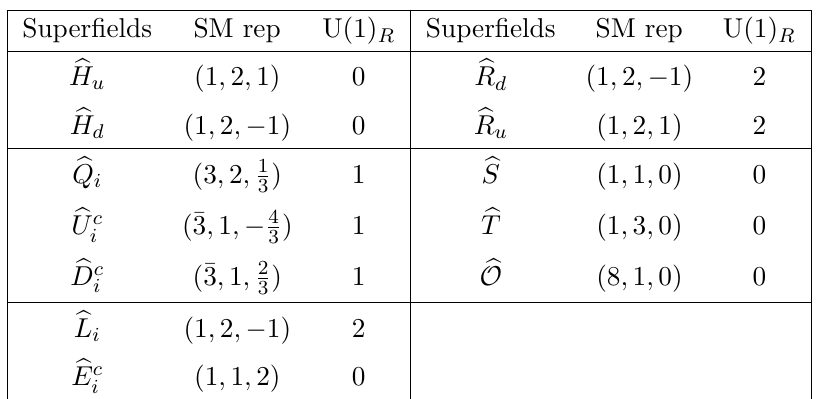
N SU(2) N U(1) c L Y as